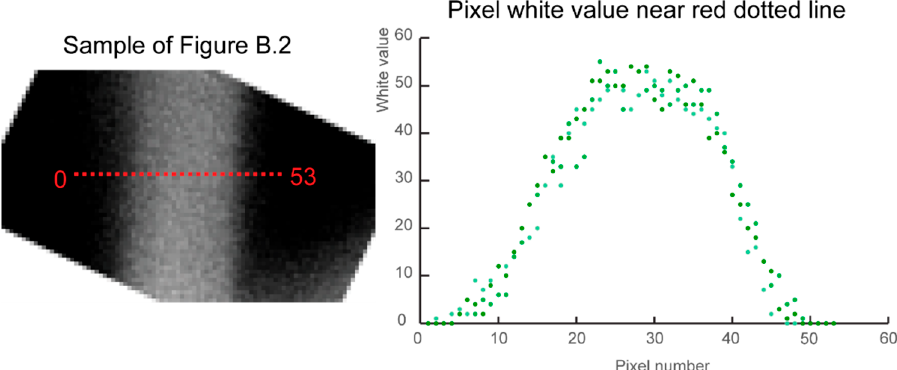
Figure A11. A detailed characterization of a fiber diameter (selected from Figure A12). The sample of Figure A12 depicts the micrograph of an example fiber, and the Pixel white value near red dotted line displays the white value of the pixel (a value from 0 to 100) for three transects across the fiber. In this example 1 pixel is equivalent to 1.52 nm. The baseline value would be selected near 9 and 47, resulting in a total pixel diameter of 38 pixels, or 57.8 nm.